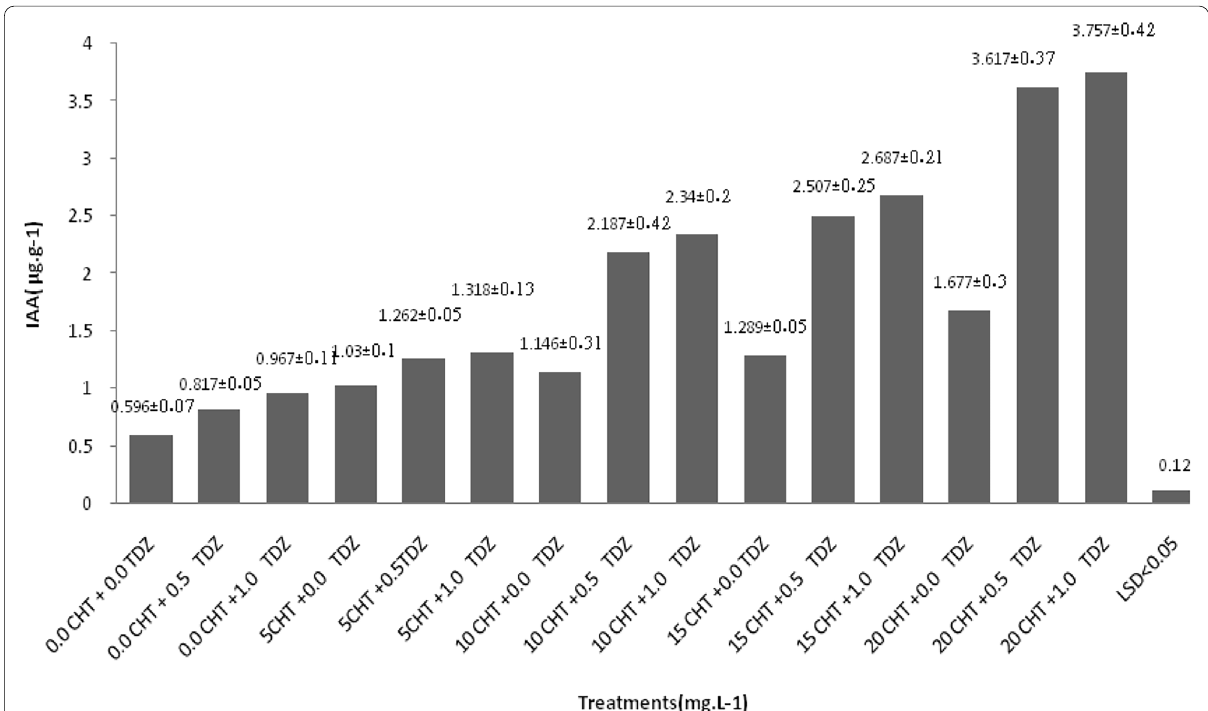
Fig. 3 Effect of chitosan (CHT) and thidiazuron (TDZ) on endogenous indole acetic acid (IAA) content.